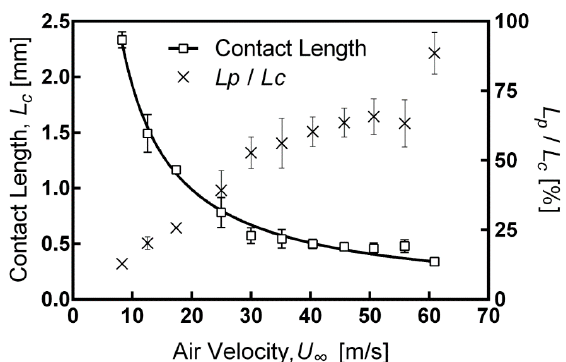
Figure 5. The critical contact length related to the critical air velocity. This indicated that the correlation between the critical contact length and air velocity was almost inversely proportional, shown as a solid fitted curve. The ratio of pore diameter and contact length were represented as the cross symbol. The ratio became higher above the freestream velocity of 30 m/s and the droplet can be considered to be being more pinned to the pore than the superhydrophobic surface.